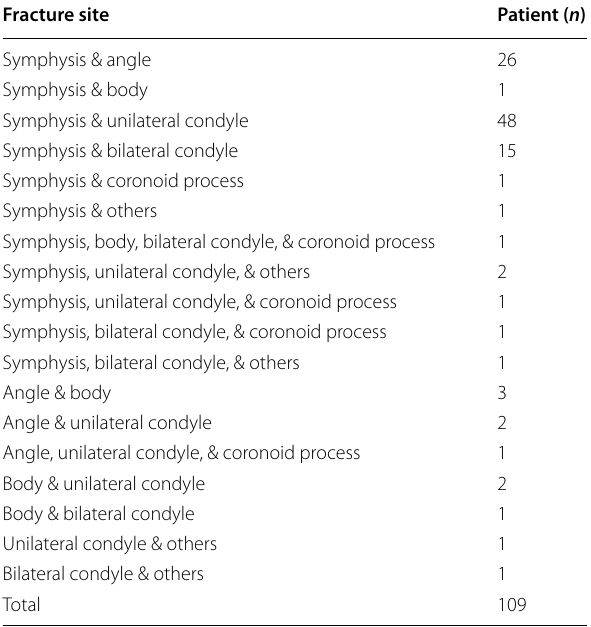
Table 3 Distribution patterns of multiple fracture